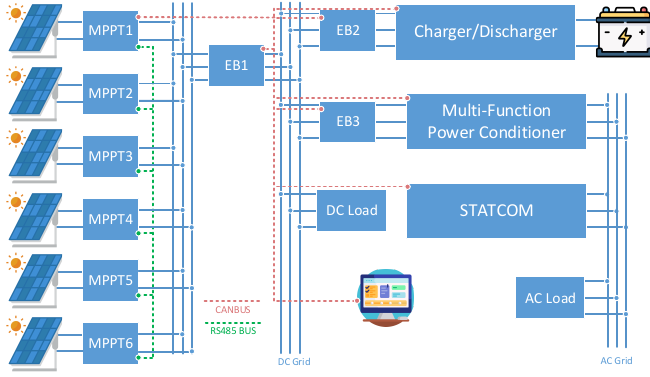
Figure 1. The proposed communication scan network for PV micro-grid system.